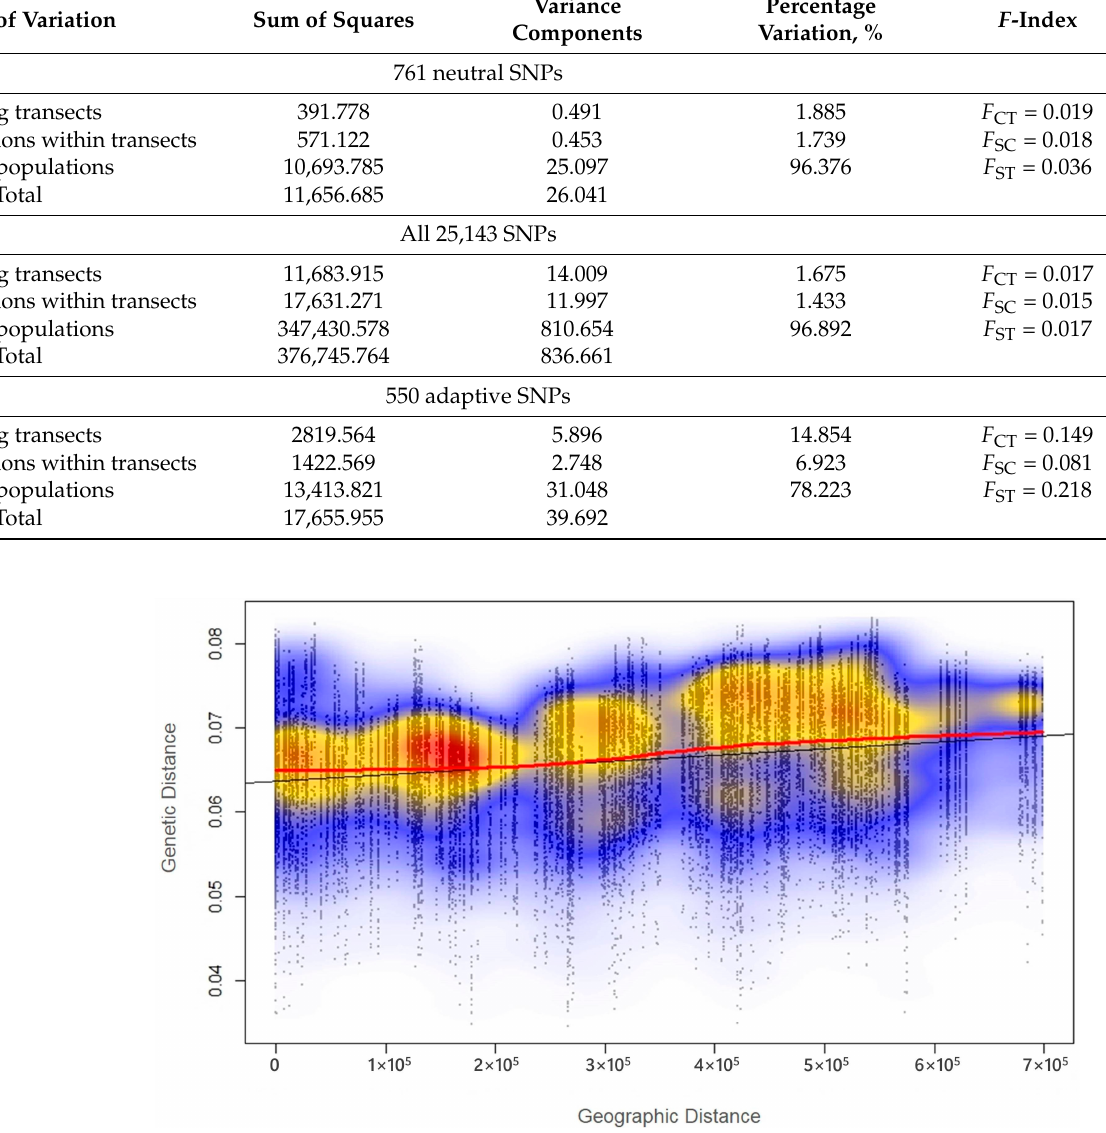
Figure 12. GO (Gene Ontology) annotation of genes in scaffolds with significant outlier SNPs.